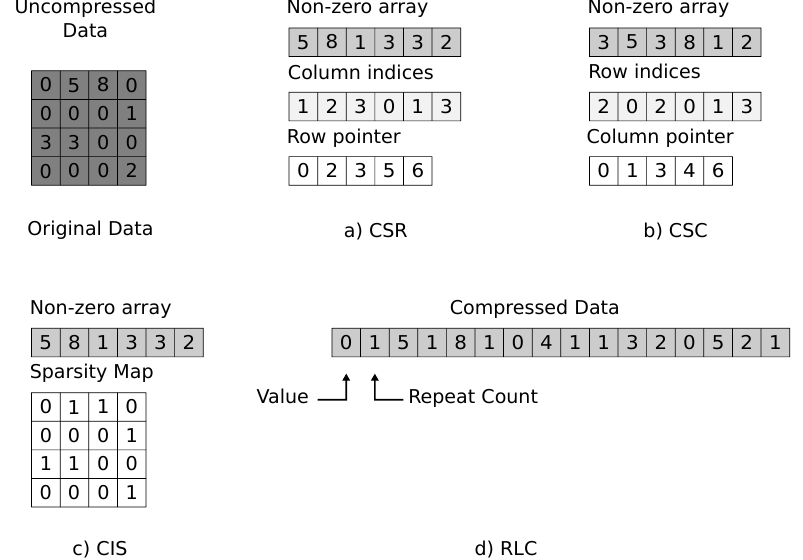
Figure 9. Comparison among different compression techniques: ( a ) Compressed Sparse Row (CSR), ( b ) Compressed Sparse Column (CSC), ( c ) Compressed Image Size (CIS), and ( d ) Run Length Coding (RLC). Table 2. Comparison of accelerators that exploit